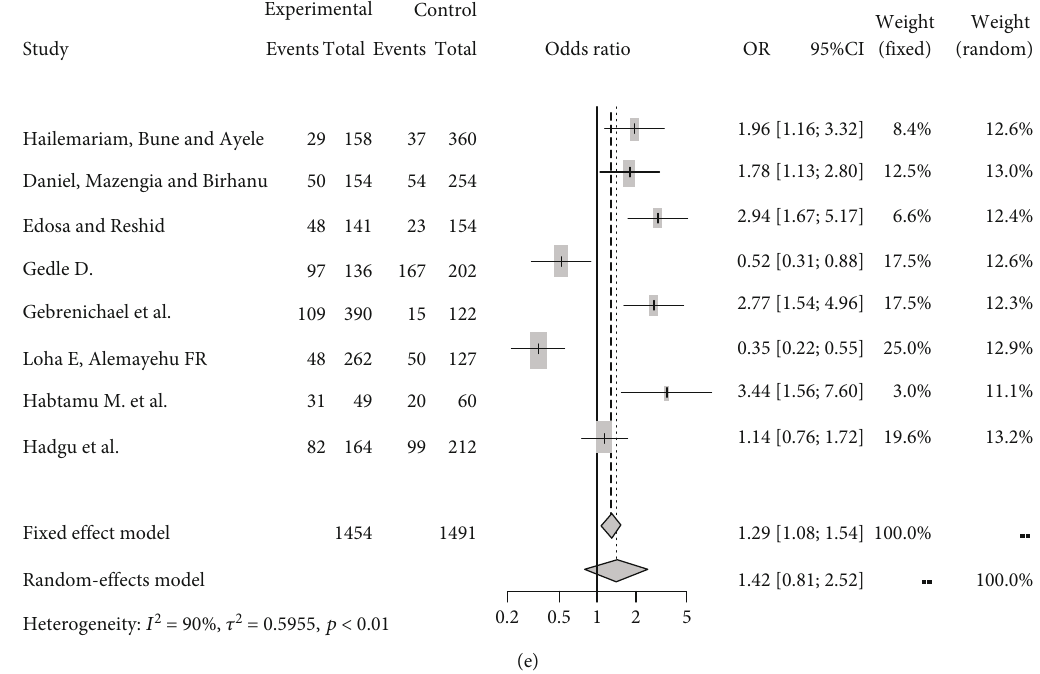
Figure 3: (a) Forest plot which shows the association between food insecurity and having opportunistic infection among adult people with HIV in Ethiopia from 2012 up to 2018. (b) Forest plot which shows the association between food insecurity and rural residence among adult people with HIV in Ethiopia from 2012 up to 2018. (c) Forest plot which shows the association between food insecurity and being female in gender among adult people with HIV in Ethiopia from 2012 up to 2018. (d) Forest plot which shows the association between food insecurity and WHO clinical stages III and IV among adult people with HIV in Ethiopia from 2012 up to 2018. (e) Forest plot which shows the association between food insecurity and CD4 count among adult people with HIV in Ethiopia from 2012 up to